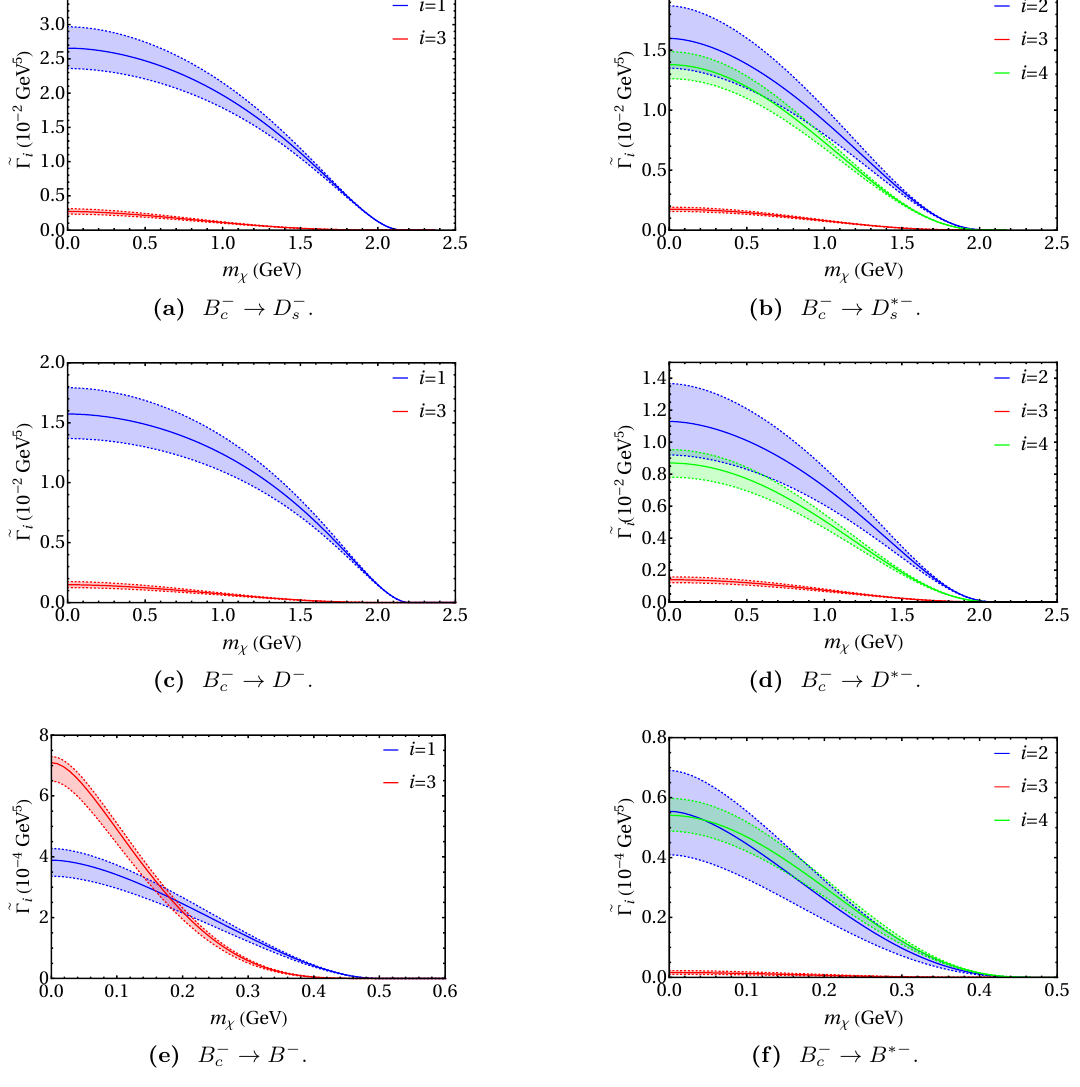
(cid:0) P ( V ) (cid:31)(cid:31) y process. The shadows c ! (cid:6)